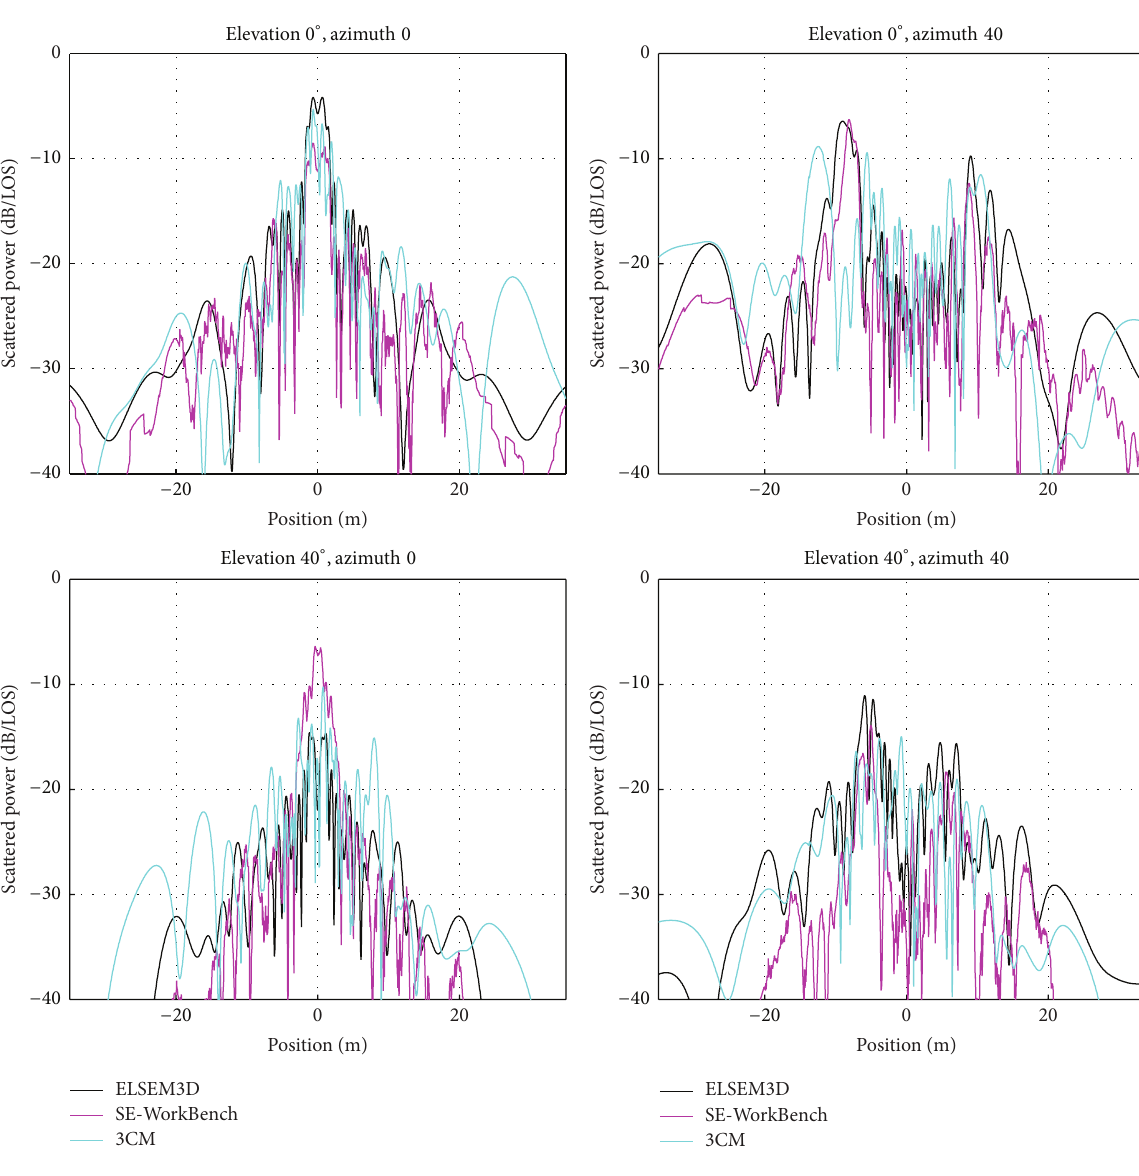
Figure 10: Total narrow-band power scattered by a complex facade for various incidence angles.